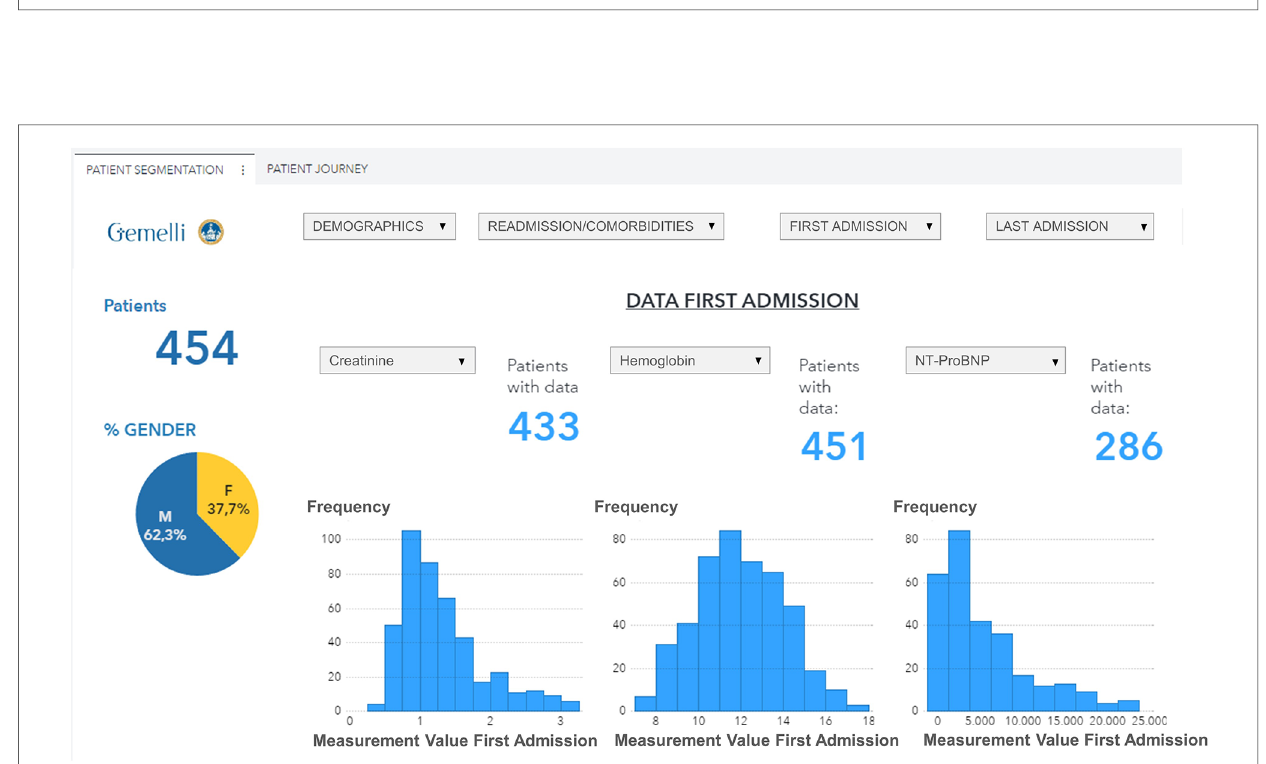
FIGURE 4 Data visualization of selected variables (eGFR, Hemoglobin, NT-ProBNP) distribution for a patient subgroup during the fi rst hospitalization event (patients with age <90 years, diabetes, and hypertension, period 2019 – 2021). eGFR, estimated Glomerular Filtration Rate.